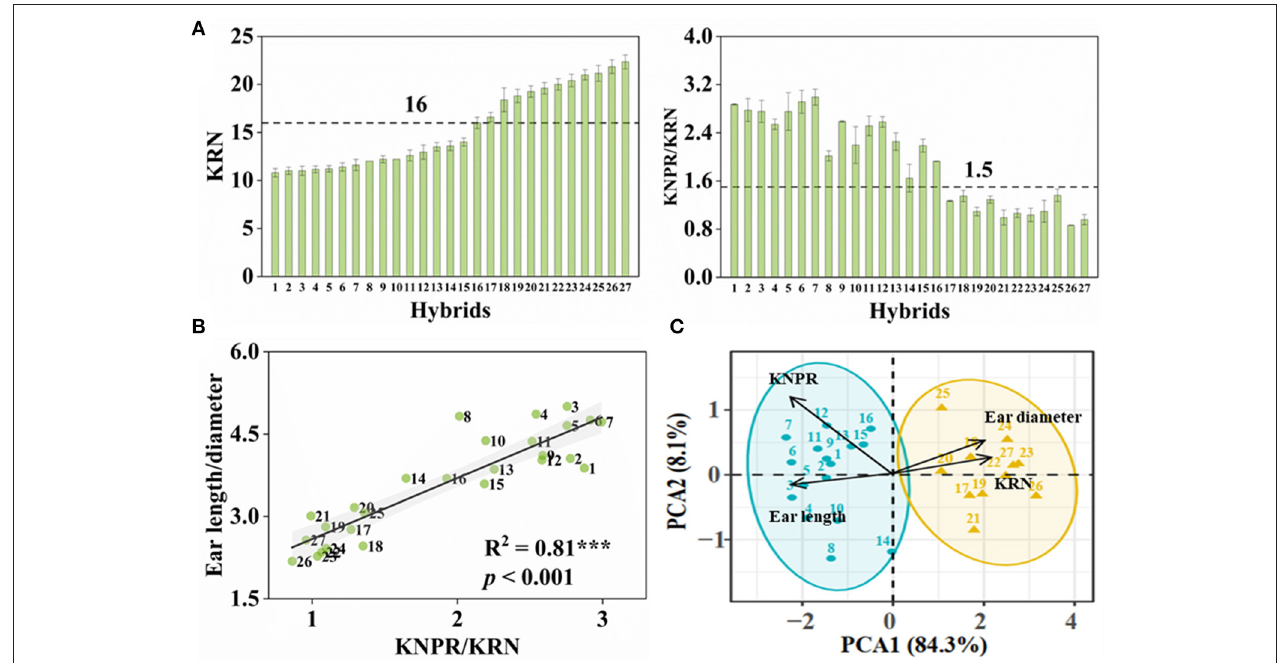
FIGURE 2 | Classification of ear types in maize hybrids. (A) Kernel row number (KRN) and kernel number per row/kernel row number (KNPR/KRN) of maize hybrids. Ears with KRN < 16 and KNPR/KRN > 1.5 were defined as the slender ears. (B) Correlation analyses between KNPR/KRN and ear length/diameter. The gray background represents confidence intervals of 95%. (C) Principal component analysis (PCA) distinguished the hybrids with the slender or stubby ears into two distinct groups. ANOSIM statistic R = 0.9814; p = 0.001. Data correspond to 27 maize hybrids. Serial numbers of 1 to 27 were donated to these hybrids by order of